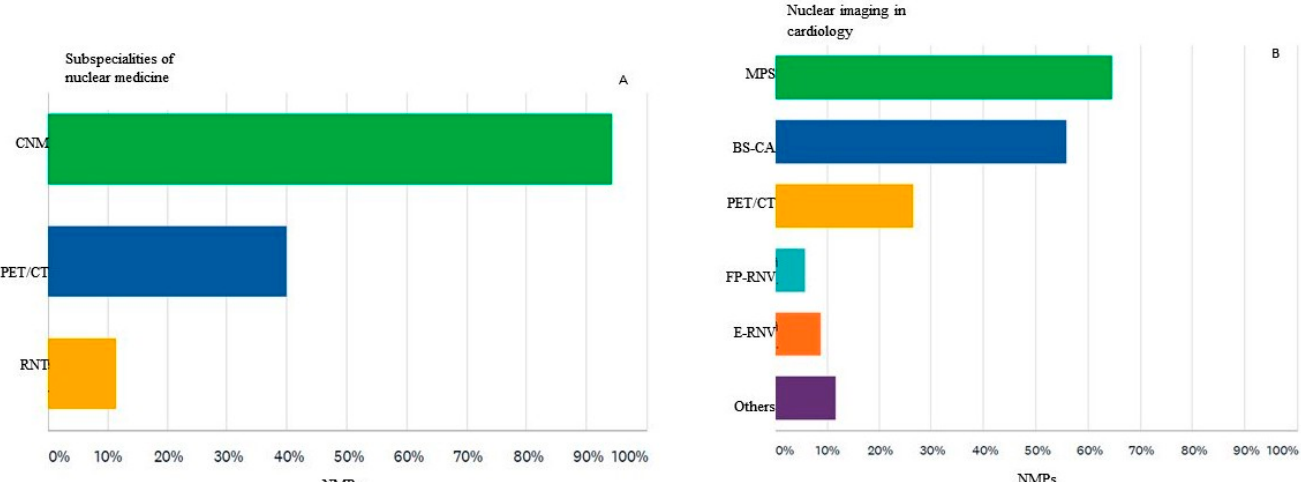
Figure 1. ( A ) Number of patients investigated by scintigraphy for all indications, routinely each month by nuclear medicine physicians. ( B ) Number of patients referred each month for bisphos- phonate scan and investigated by nuclear medicine physicians involved in the diagnosis of CA.